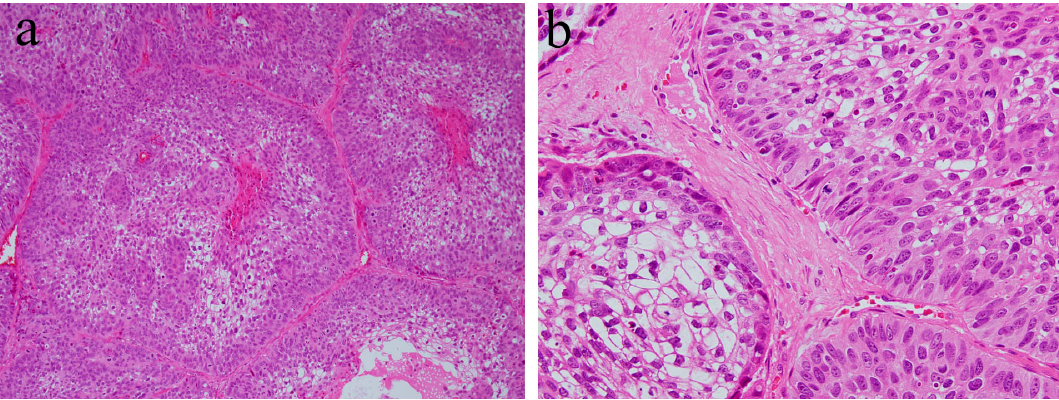
Figure 6. Histopathological features of ameloblastic carcinoma. ( a ) Follicular growth patterns of ameloblastic carcinoma. HE staining, magnification ×40. ( b ) Follicular tumor nests of ameloblastic carcinoma. HE staining, magnification